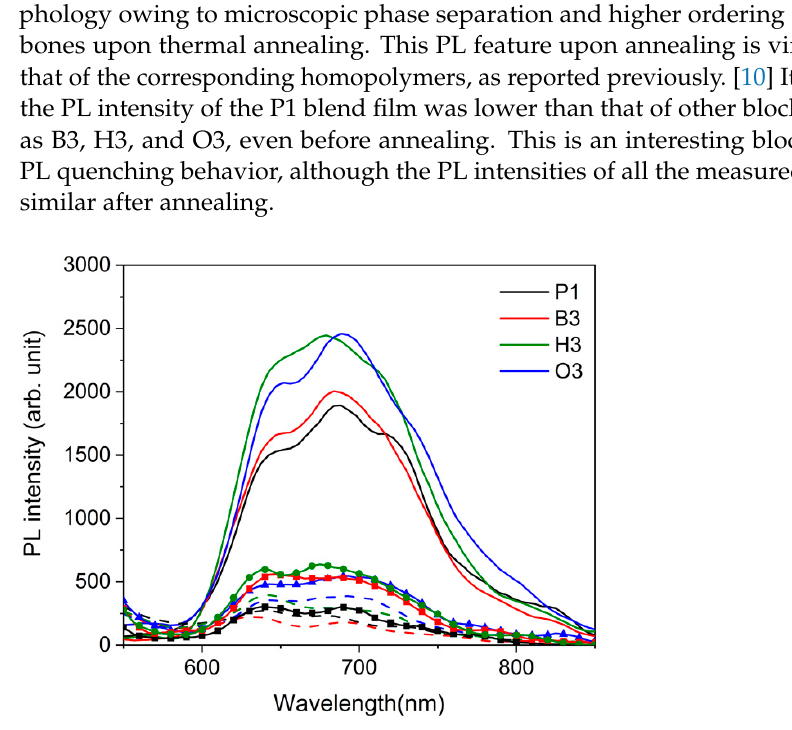
Figure 5. Selected PL spectra of pristine copolymer films (solid lines), copolymer:PCBM blend films before annealing (dashed lines), and blend films after annealing (solid lines with symbols).